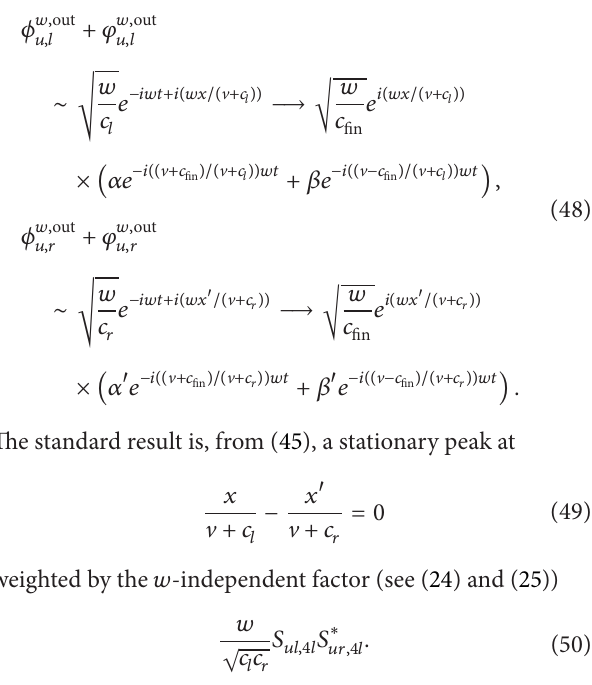
with 𝛼 󸀠 = ((𝑐 𝑟 + 𝑐 )/2√𝑐 𝑐 𝑟